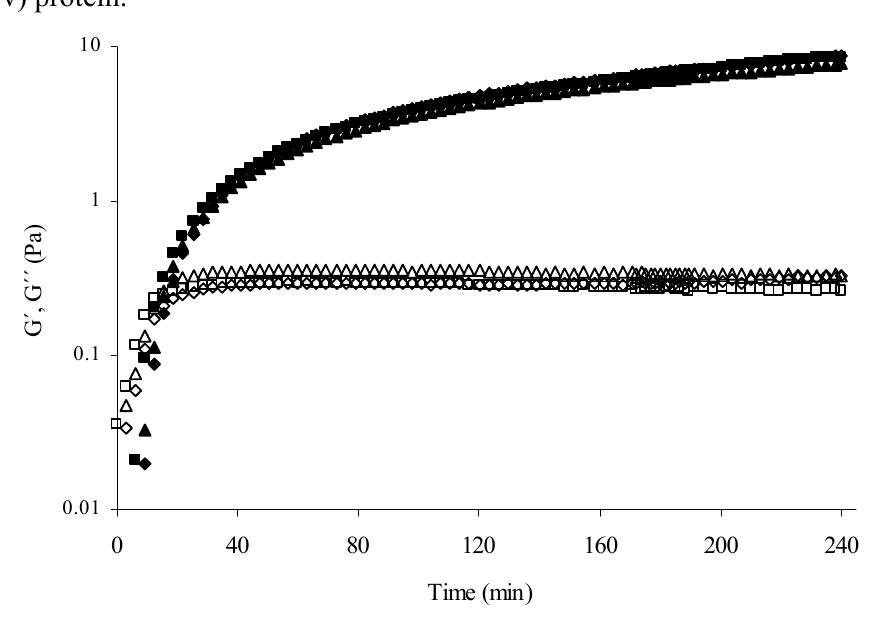
Figure 1. Monitoring the storage (G’) and loss (G’’) modulus of MBAX (G’  , G’’  ), MBAX-insulin (G’ ▲ , G’’ ) and MBAX- β -lactoglobulin (G’  , G’’ ) solutions during gelation by laccase at 25°C, 0.25 Hz and 5% strain. Gels at 2.5% (w/v) in MBAX and 0.1% (w/v) protein.